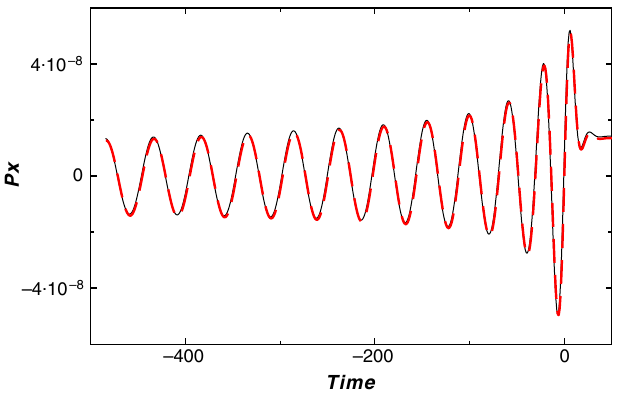
FIG. 6. Linear momentum in the x direction.